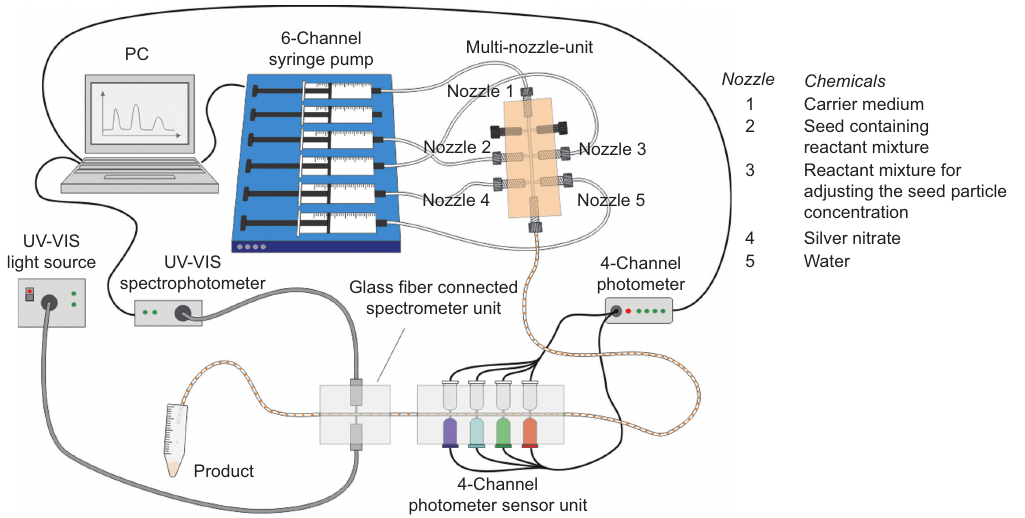
Figure 7 Micro-flow-through setup for the combinatorial synthesis of gold/silver core/shell